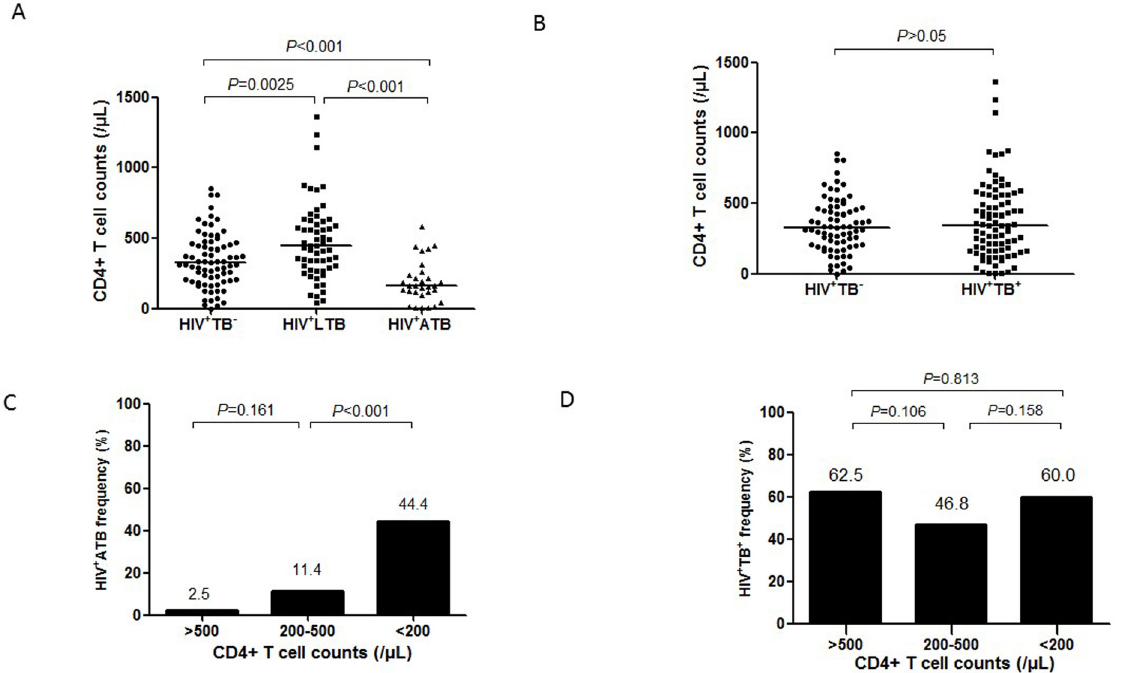
Fig 1. Hierarchy low CD4+ T-cell counts associated with active TB but not M.tb coinfection. A . CD4+ T cell counts in groups of HIV-1 + TB - , HIV-1 + LTB and HIV-1 + ATB. B . CD4+ T cell counts in HIV-1-infected individuals with or without M . tb co-infection (LTB+ATB). The horizontal lines represent the median CD4+ T cell counts in each group. C and D . Changes of the incidence of active TB (C.) and M . tb co-infection (D.) in HIV-1 + individuals with different CD4+ T cell counts. Data were analyzed using chi-square test and P values are